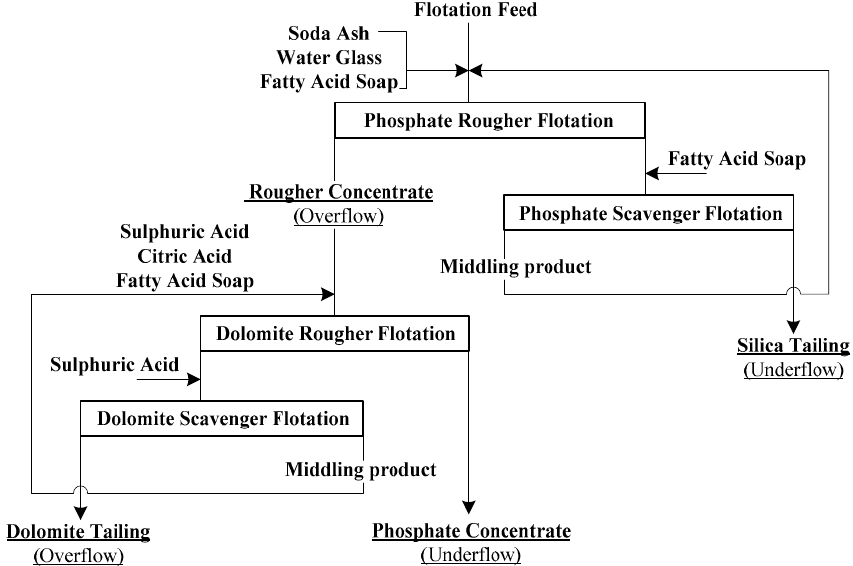
Figure 2. The direct-reverse flotation process for beneficiation of calcareous-siliceous phosphate ore [9].